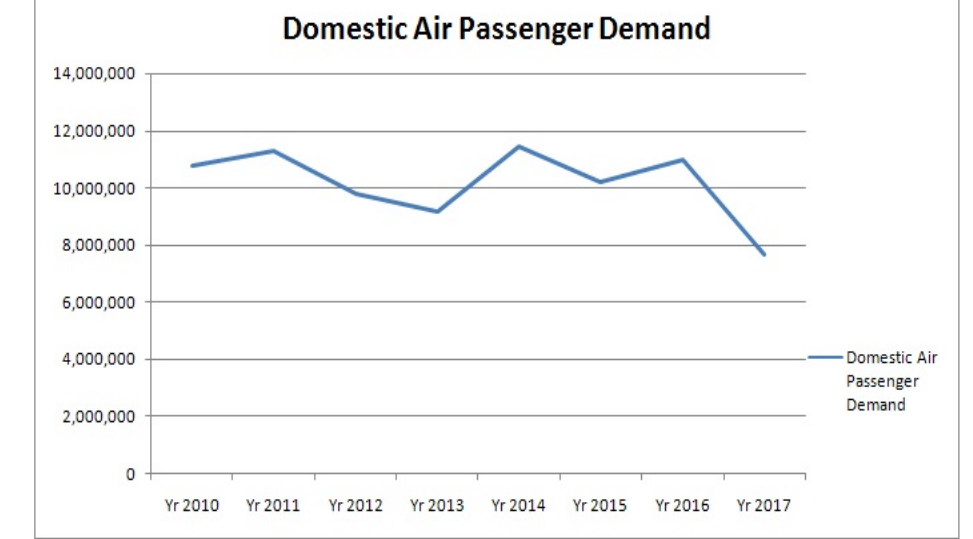
Figure 1. Time Series Graph Showing International Air Passenger Demand in Nigeria from Year 2001 to 2017.